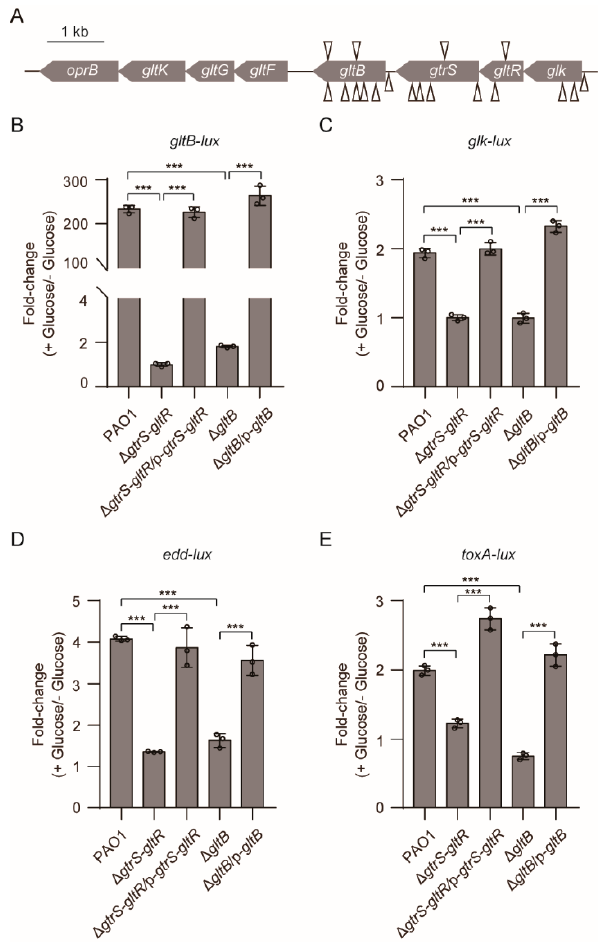
Figure 4. Disruption of gltB decreases the expression of GltR-regulated genes in response to glucose. ( A ) Schematic representation of the transposon insertion site. Gene is shown by arrow and the triangle indicated the mariner-based transposon. The direction (relative to the genomic scaffold) of gentamicin resistance cassette in transposon is provided (forward, upper triangles; reverse, lower triangles). ( B – E ) The effect of either gtrS-gltR or gltB deletion on the glucose-induced expression of known GltR–regulated genes. Bacteria were grown in tubes containing M9 MM supplemented with (+) or without ( − ) 5 mM glucose at 37 °C with shaking (250 rpm) for 8 h, and the fold-change in gene expression (induced by glucose) was determined. Data from n = 3 biological replicates reported as mean ± SD. (*** p < 0.001; Student’s two-tailed t -test). PAO1, Δ gtrS-gltR, and Δ gltB harbor an empty pAK1900 vector as control; p- gtrS-gltR denotes the pAK1900- gtrS-gltR plasmid; p- gltB denotes the pAK1900- gltB plasmid.